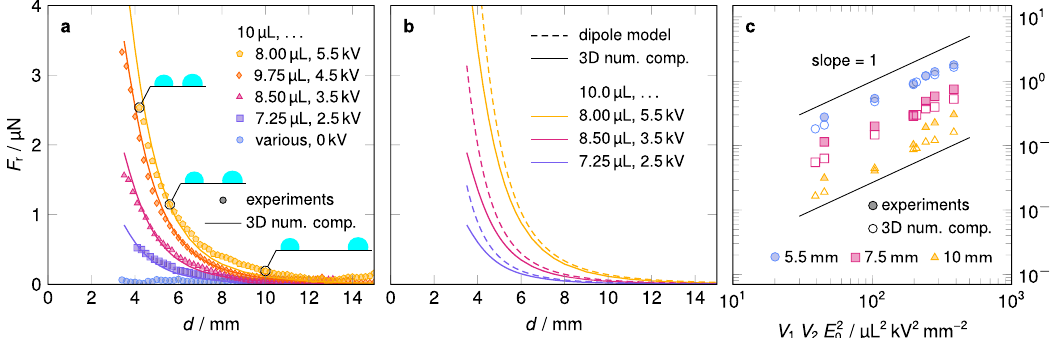
Fig. 4 Repulsion force F r obtained from experiments, three-dimensional numerical computations and the semi-analytical model of interacting dipoles. In all diagrams F r is plotted along the ordinate. a Repulsion force F r as a function of distance between the droplets. The fi lled symbols represent the averaged experimental data for different applied voltages Δ ϕ and droplet volumes V 1 and V 2 , respectively. Lines of the same color correspond to the numerical computations sharing the same parameters. At least six single experiments were averaged to obtain the data points. The insets show schematics of the droplet con fi guration for d equal to 4.2, 5.6, and 10 mm, respectively. b The same as in a , but comparing the data of the numerical computations (solid lines) and the interacting dipole model (dashed lines). The colors indicate different parameter combinations. Using Mathematica 66 we found the integral in Eq. (5) to be 0.244 for a contact angle of 106°, hence Θ equals 0.589 for the present droplets. c Repulsion force F r as function of the product V V E 2 for three different values of d . The fi lled and empty symbols represent data from measurements and numerical computations, respectively. For 1 2 0 fi xed d each data point corresponds to a different combination of the parameters V V Δ ϕ . The solid straight lines with unity slope indicate the 1 , 2 , and idealized linear scaling F r (cid:5) V 1 V 2 E 2 . The maximum standard error of the mean force is less than 0.1 μ N for all experimental data points. As a result, the 0 corresponding error bars would be mostly smaller than the data symbols, which is why they are omitted.